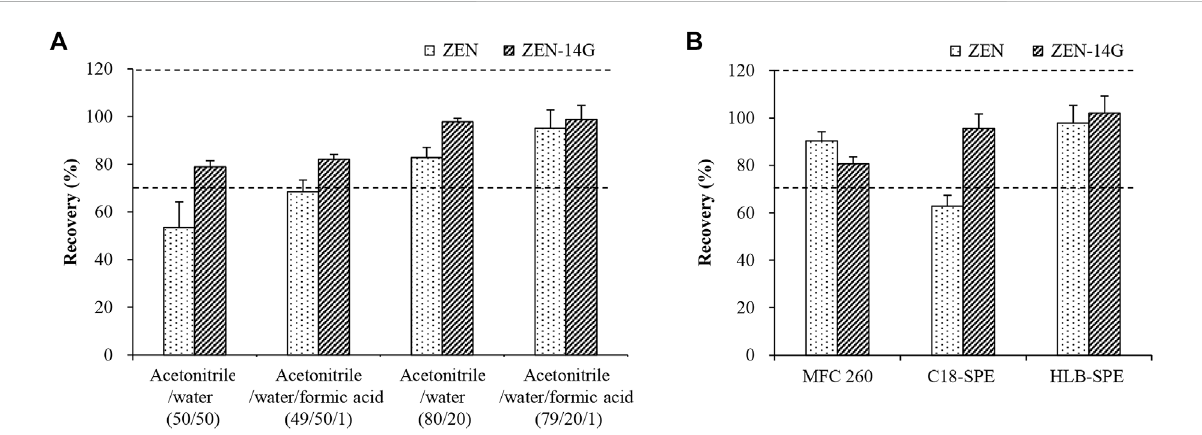
FIGURE 1 Comparison ofthe extractionef fi ciencies for ZEN and ZEN-14G using the four candidateextractionsolvents (A) and puri fi cation ef fi ciencies by three different clean-up cartridges (B) using spiked formula feed samples (50 μ g kg − 1 ). Data are presented as the mean ± standard deviation (SD). Acceptable recoveries are in the range of the two dashed lines (70 –